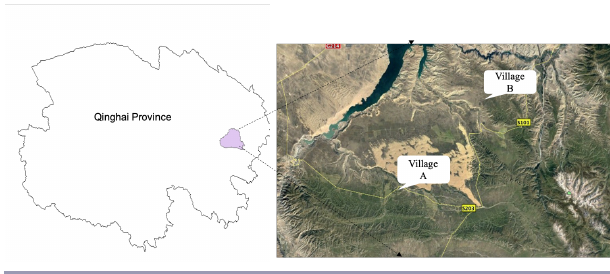
Fig. 1 . Location of the two study sites, Village A (lower) and Village B (upper) in Guinan County, Qinghai Province, P. R.